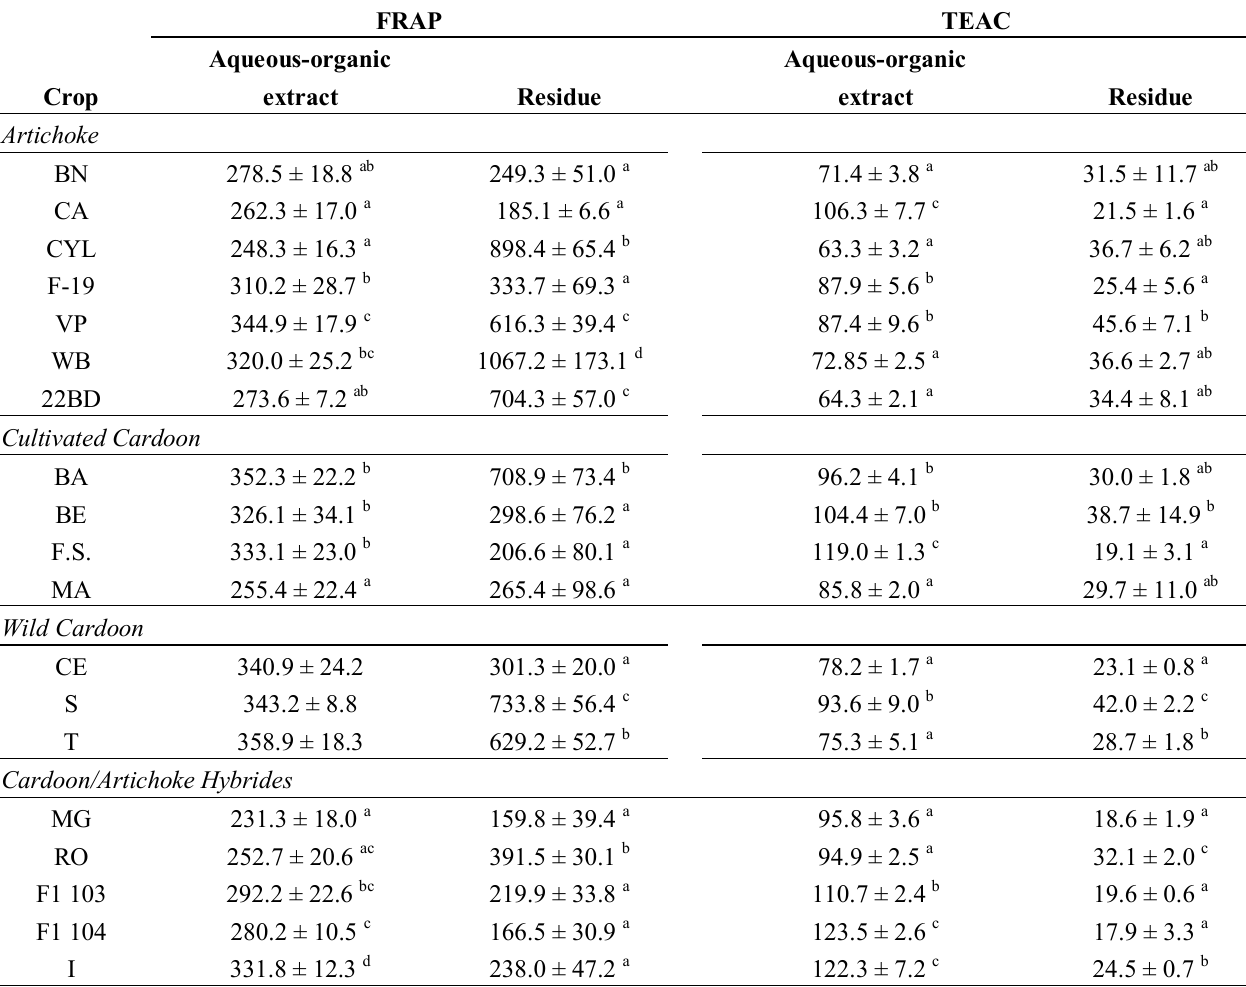
Table 2. Ferric Reducing Antioxidant Power (FRAP) values (mmol/kg d.w.) and